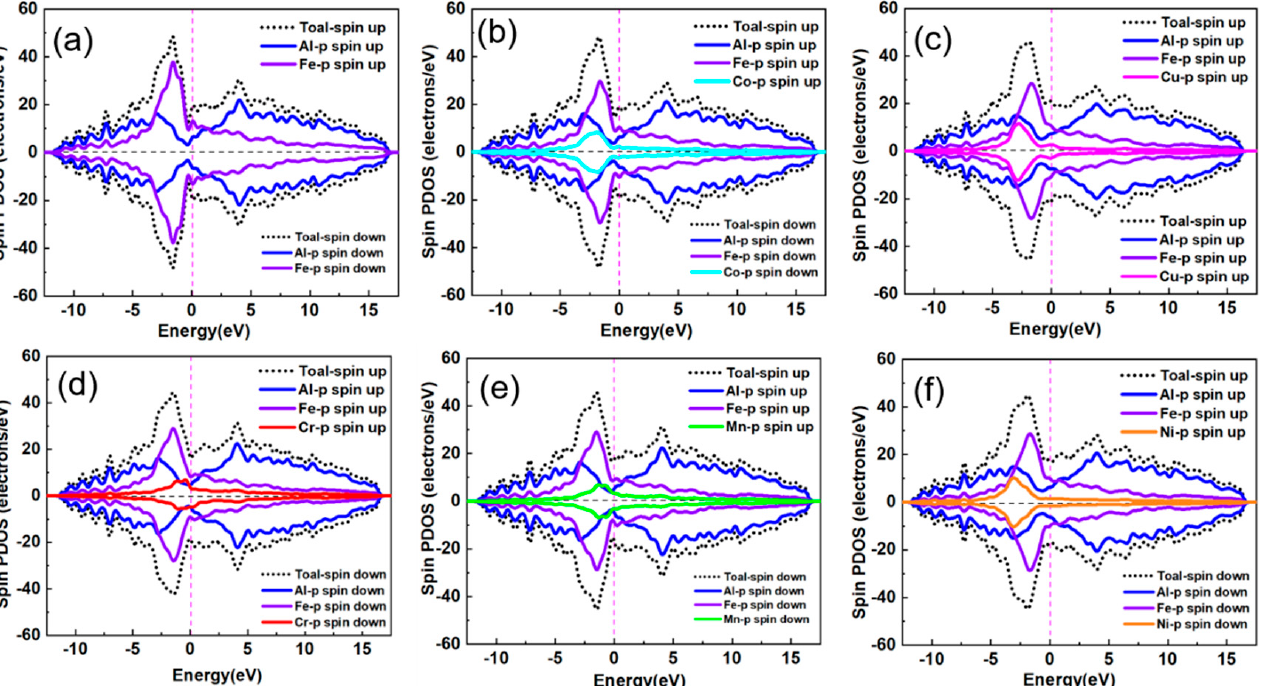
Figure 3. The spin-polarized total density of states (TDOS) and partial density of states (PDOS) of Al 13 (Fe,M) 4 phases with Co, Cu, Cr, Mn, and Ni doping. Dashed lines represent the Fermi level. ( a ) Al 13 Fe 4 , ( b ) Al 13 (Fe,Co) 4 , ( c ) Al 13 (Fe,Cu) 4 , ( d ) Al 13 (Fe,Cr) 4 , ( e ) Al 13 (Fe,Mn) 4 , ( f ) Al 13 (Fe,Ni) 4 .